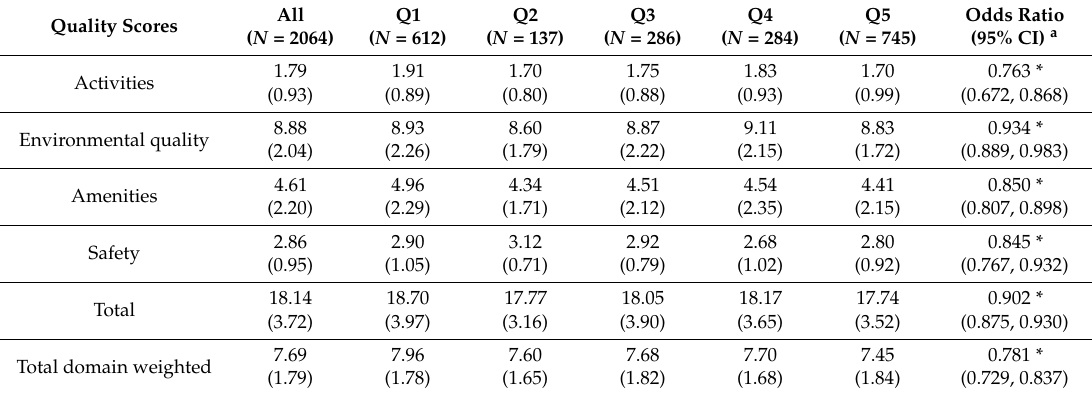
Table 2. Green space quality scores according to neighbourhood socioeconomic deprivation